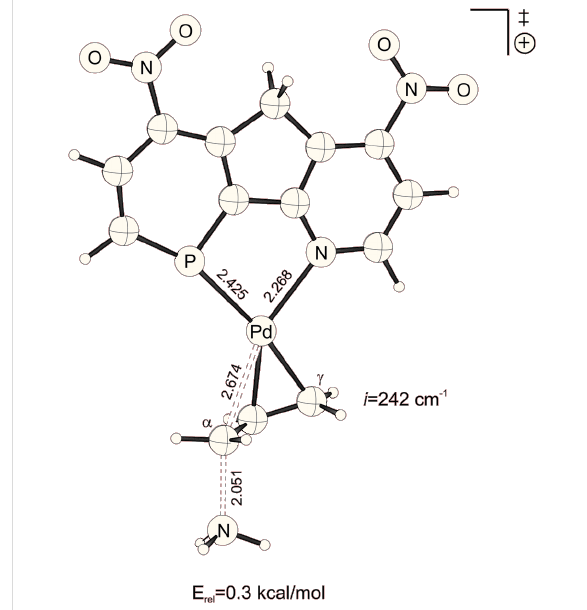
Figure 2: Transition structure for the energetically disfavored cis to phosphorus addition of ammonia at the Pd-η 3 -allylic intermediate (B3LYP/6-31G* (C, H, N, P, O), /SDD (Pd)). Bond distances are given in Å.